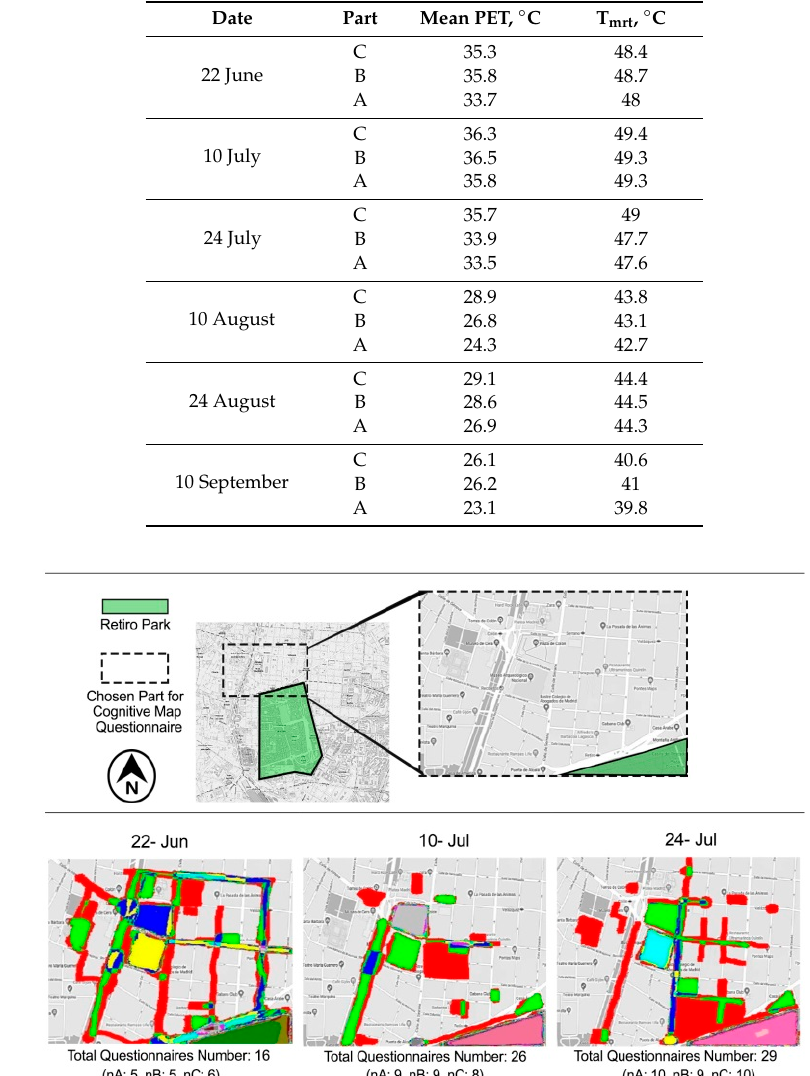
Table 5. Values of the T mrt ( ◦ C) and average values for physiological equivalent temperature (PET; ◦ C) in part A, B and C.